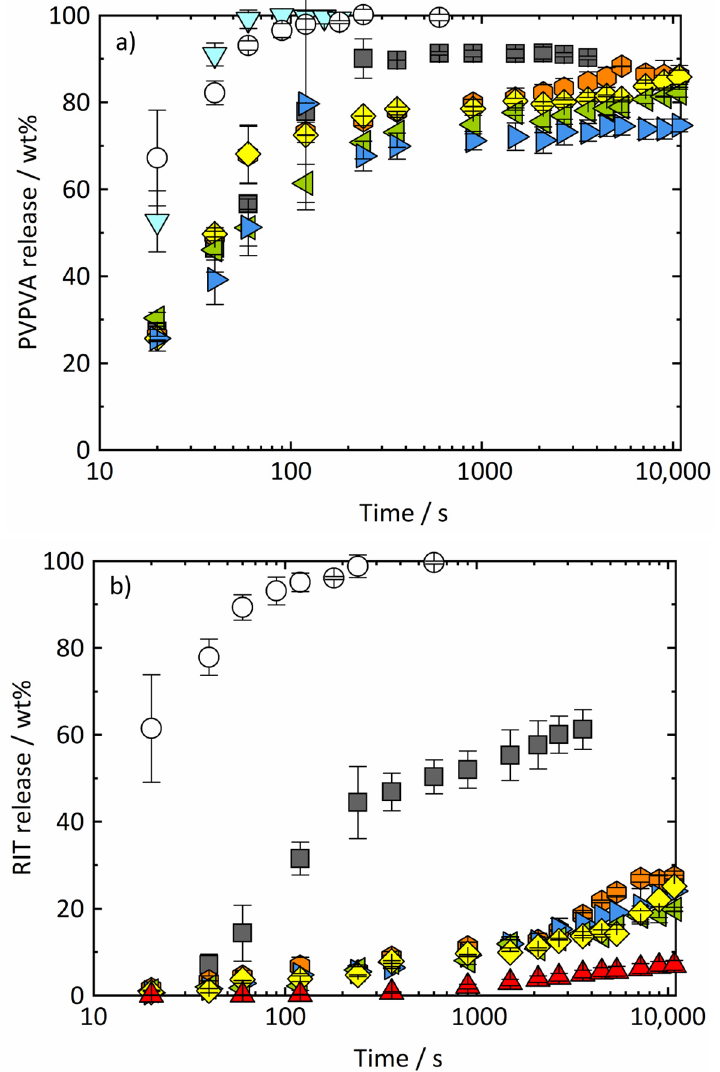
Figure 5. Release profiles of ( a ) PVPVA and ( b ) RIT in the dissolution medium over time at 25 °C and 0.1 MPa for ASDs with DLs of 0 wt% (light blue triangles downwards), 10 wt% (white circles), 20 wt% (gray squares), 25 wt% (orange hexagons), 30 wt% (yellow diamonds), 35 wt% (green triangles to the left), 40 wt% (dark blue triangles to the right), and 100 wt% (red triangles upwards) measured in this work.